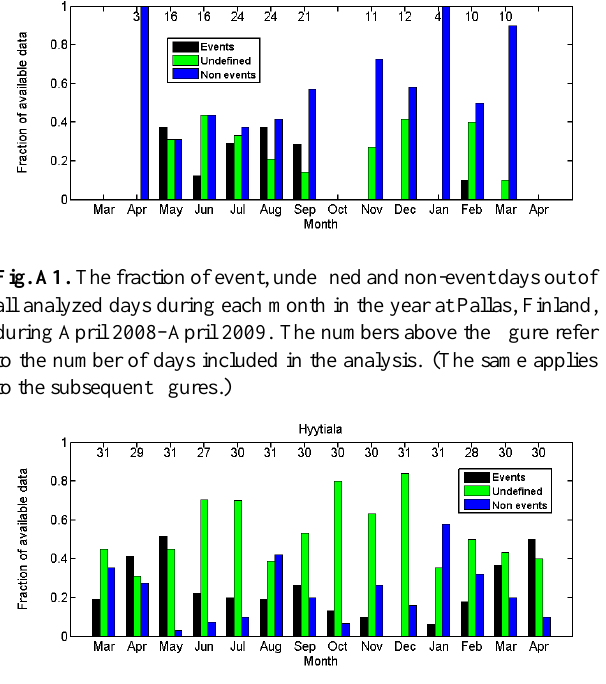
Fig. A2. The fraction of event, undefined and non-event days out of all analyzed days during each month in the year at Hyyti¨al¨a, Finland, during March 2008–April 2009.